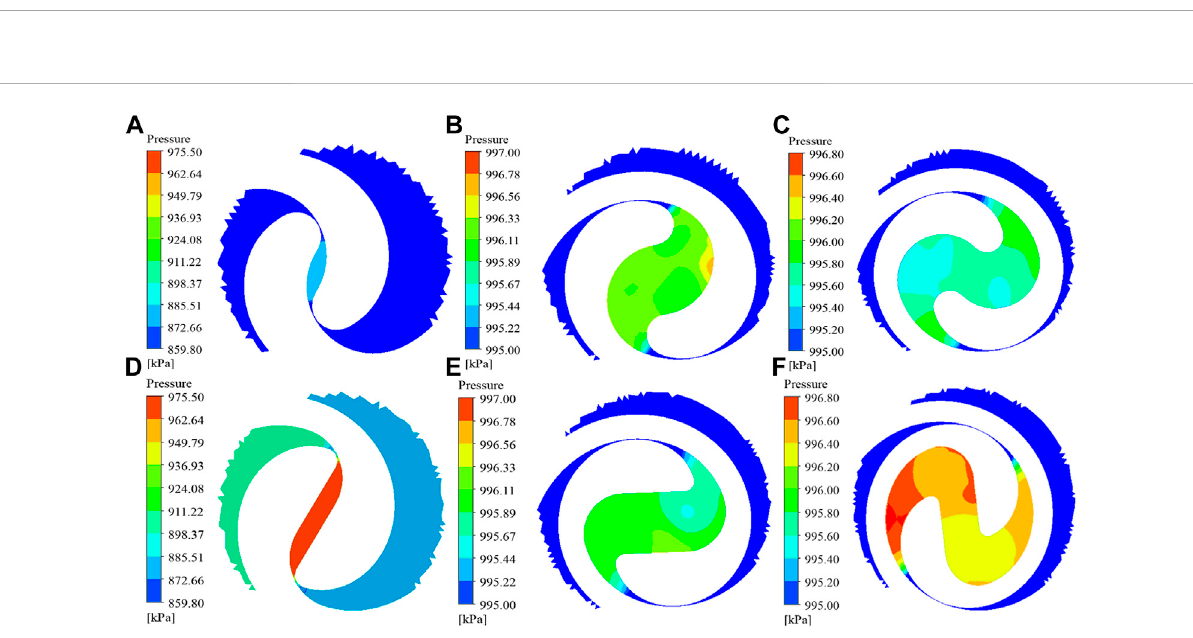
FIGURE 9 (A – C) and (D – F) are the pressure distribution of the spindle angle at 60 ° , 180 ° and 240 ° under PMP correction and EA-SAL correction,